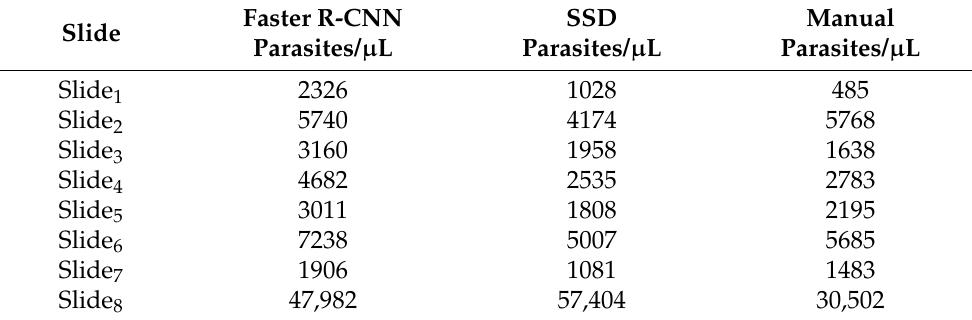
Table 3. Malaria parasitemia on a unique set of each validation thick blood smear slide with corresponding clinical interpretation.